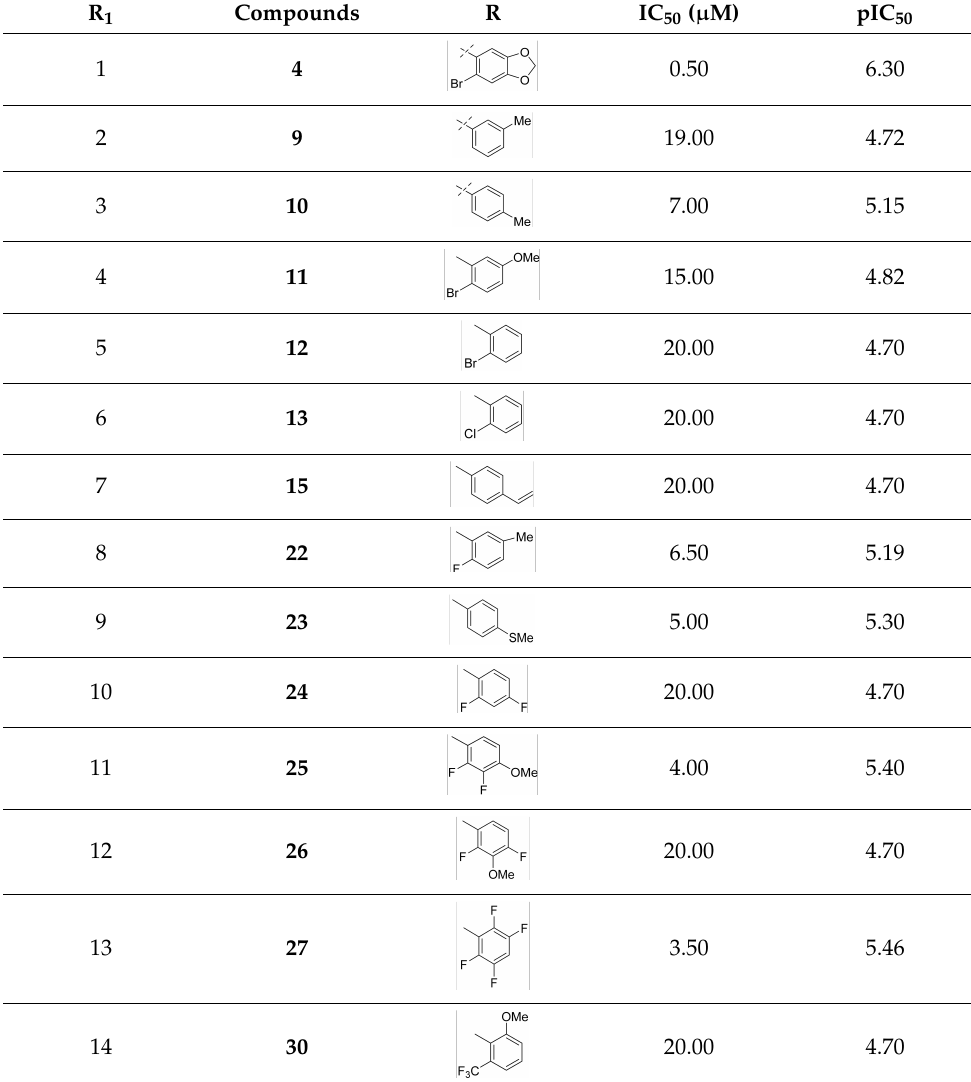
Table 1. Different substituents of a common core with biological activities in IC 50 and pIC 50 values [10]. R